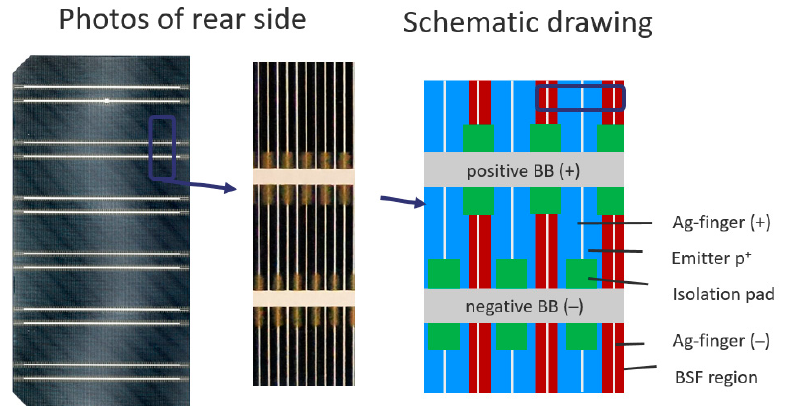
Figure 5. Picture of the back side of a four-busbar ZEBRA solar cell ( left , middle ) and schematic drawing of the back-side metallisation of ZEBRA ( right ) [13].